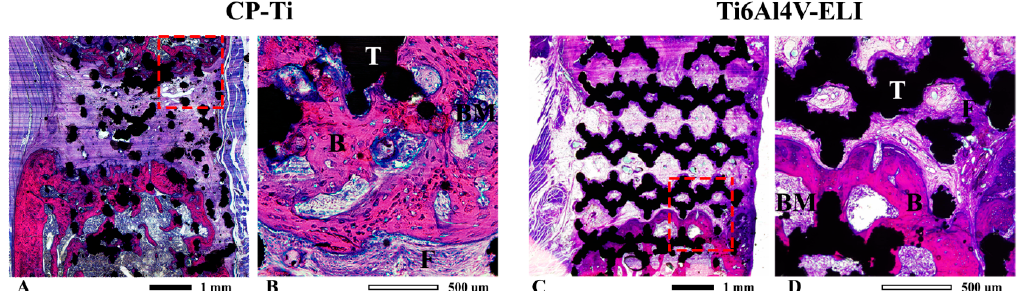
Figure 5. Histological evaluation of bone bridging. Representative transversal sections of femur defects eleven weeks after implantation of porous titanium implants; CP-Ti ( A ) and Ti6Al4V-ELI ( C ), including detailed view for CP-Ti ( B ) and Ti6Al4V-ELI ( D ). Sections are stained with basic fuchsine and methylene blue. Basic fuchsine stains bone pink, methylene blue stains fibrous tissue blue. B = bone, BM = bone marrow, F = fibrous tissue, T = titanium.